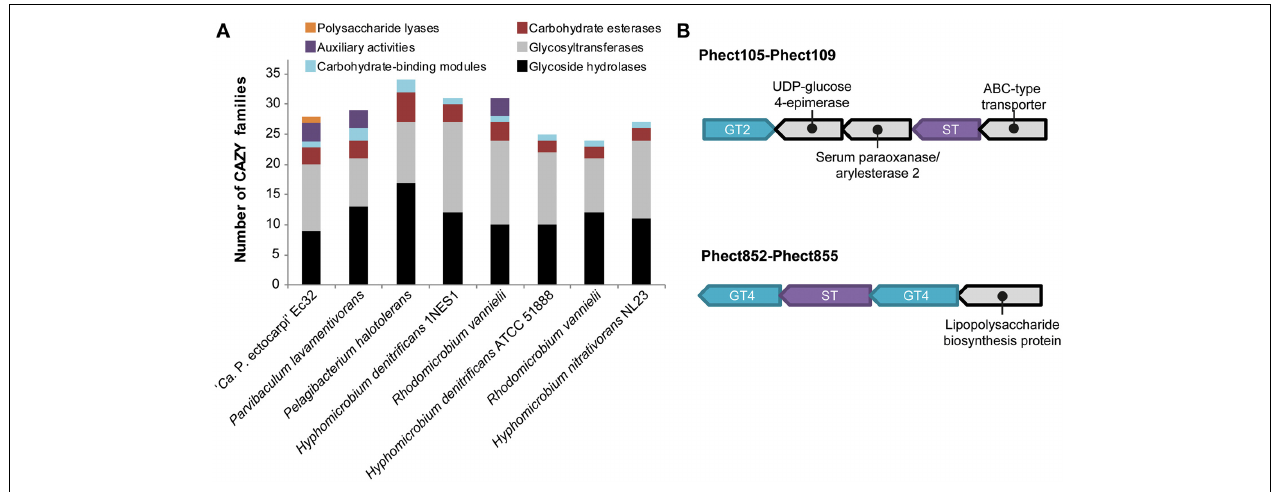
FIGURE 3 | Carbohydrate modifying enzymes. (A) Number of CAZY families in the genome of “ Ca . Phaeomarinobacter ectocarpi” Ec32 and selected Rhizobiales . (B) Organization of genes possibly involved in the degradation of sulfated fucans. GT, glycosyltransferase; ST, sulfotransferase.